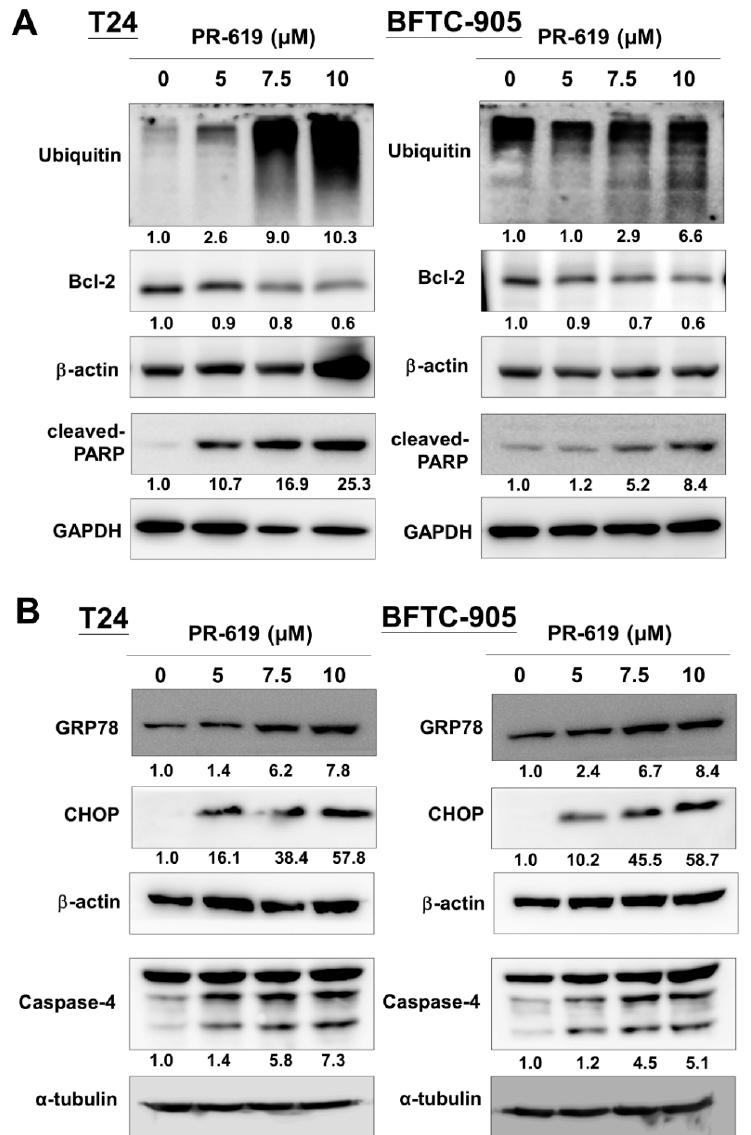
Figure 2. PR-619 induced ER stress and ER-stress-related apoptosis in human urothelial carcinoma